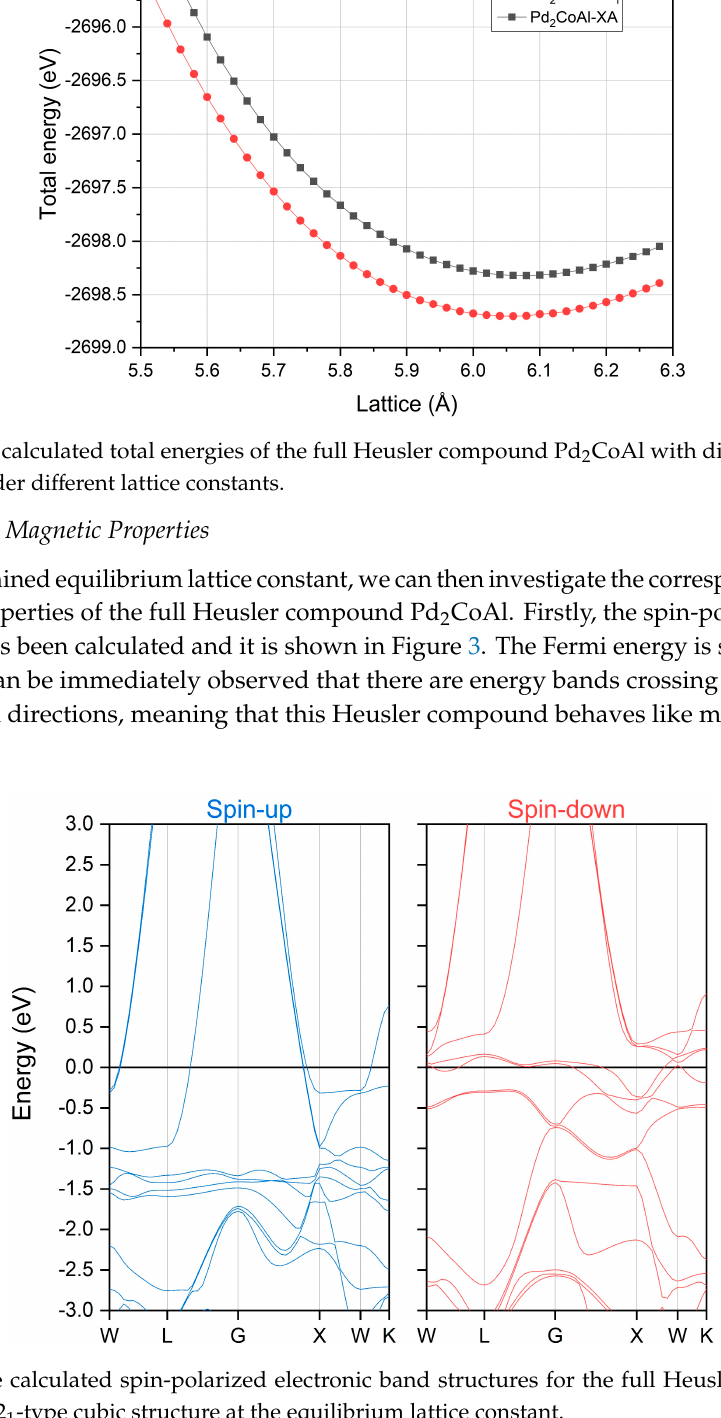
Figure 2. The calculated total energies of the full Heusler compound Pd 2 CoAl with different crystal structures under different lattice constants. Table 1. The calculated equilibrium lattice constant, total and atom-resolved magnetic moment.